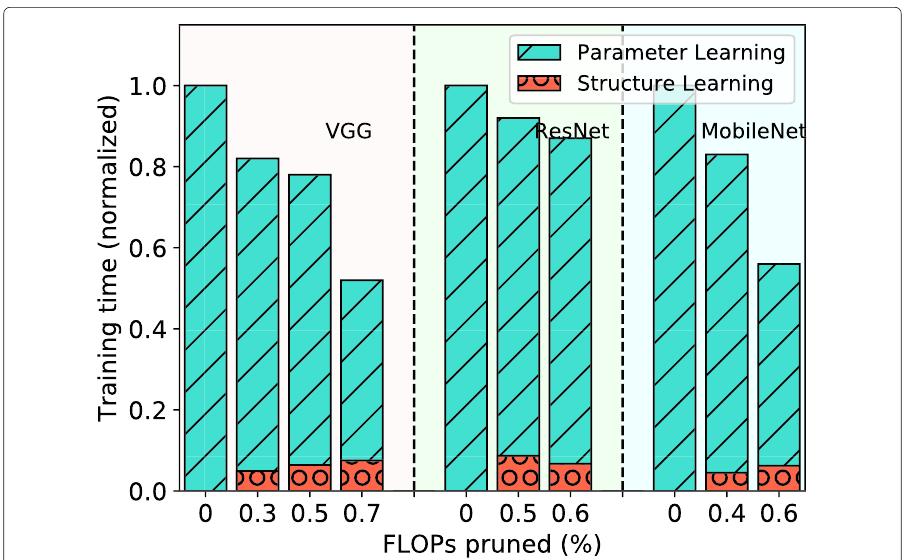
Fig. 12 The normalized training time w.r.t. different pruning rates and CNN architectures. The training time refers to the total time spent in training the neural networks to achieve the highest testing